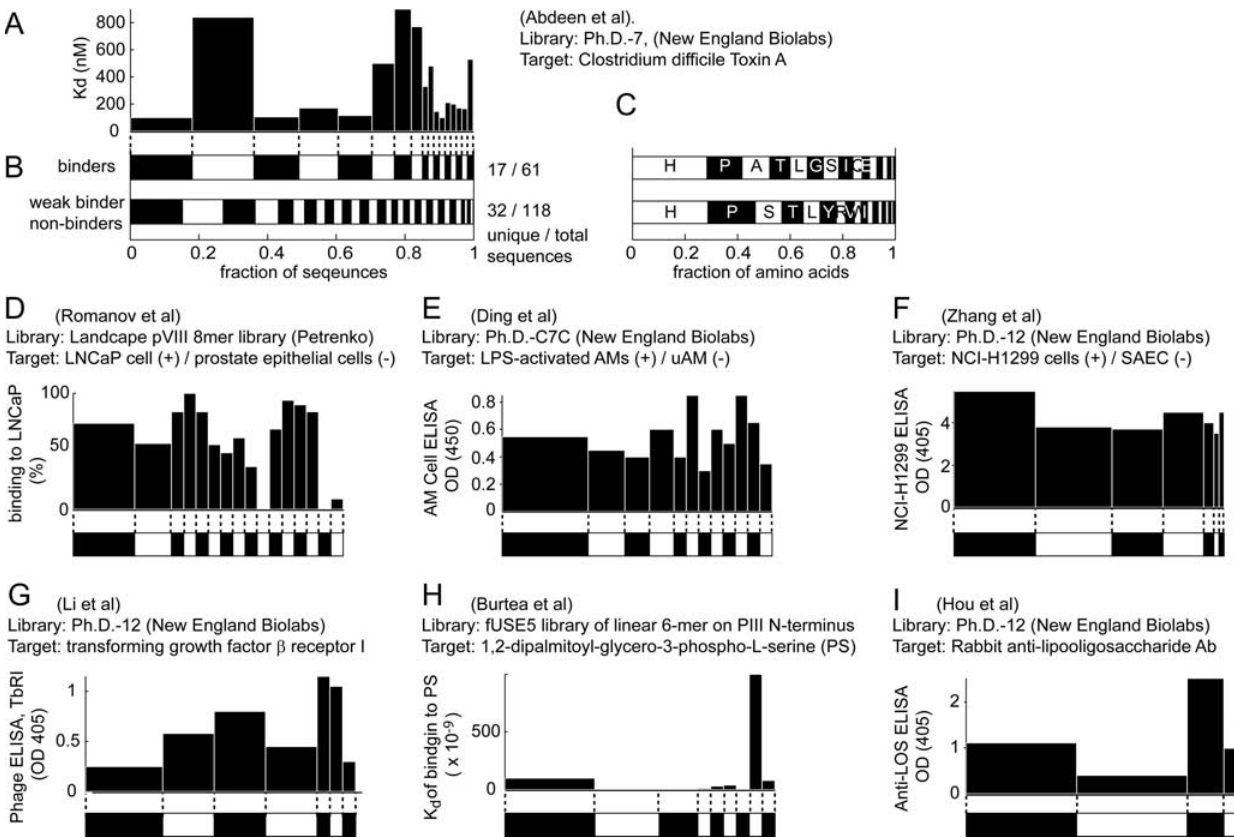
Figure 5. There is no correlation between the abundance of binding clones and their binding ability. (A-C) This example is from Feig and co-workers, who identified peptides that bind to Clostridium difficile toxins. After 4 rounds of panning, 61 clones were identified as binders and 118 clones had weak (or no) binding affinity [50]. (A) The K the clones that bind. The horizontal position of each bar corresponds to the binder clone shown in the top stacked bar in (B) . The width of the bar in A and B indicates the abundance of each clone. The binding affinity of each clone and its abundance in the sub- library are not correlated. (B) The distribution of the diversity in sub-populations of binders and non-binders are similar (both have several highly abundant clones). (C) Amino acid abundances are similar. (D-I) Results from other screens in the literature have the same trend as those in A: binding ability of the phage clones and their abundances are not correlated